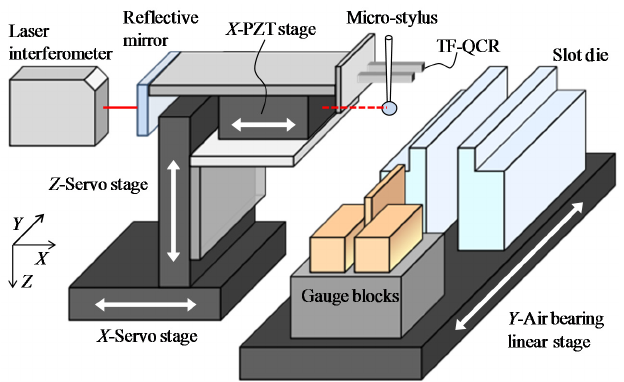
Figure 2. Experimental configuration of the micro-CMM (micro-coordinate measurement machine) by using a shear-mode micro-probe.